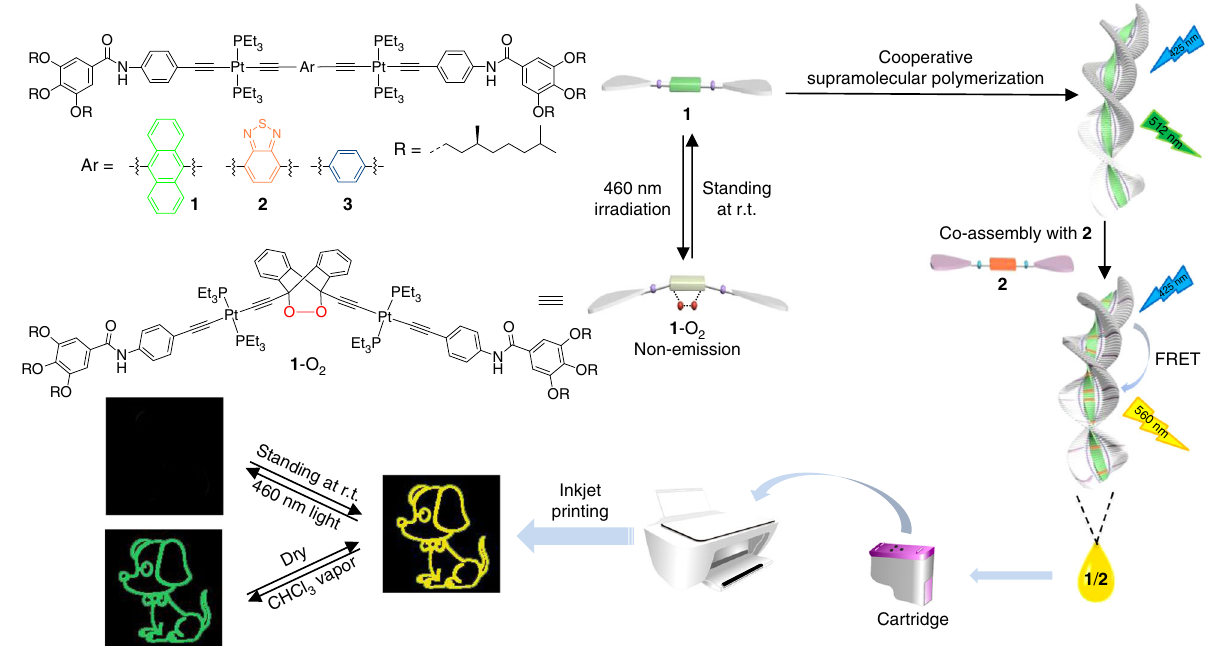
Fig. 1 Molecular structures design and anti-counterfeiting applications. Schematic illustration of monomer 1 with anthracene ‒ endoperoxide photo- switching, and cartoon representation for the resulting supramolecular polymers toward fl uorescent anti-counterfeiting